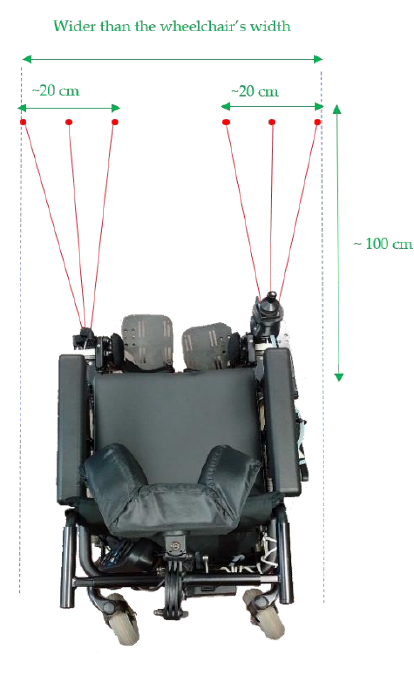
Figure 6. Sensor positions.